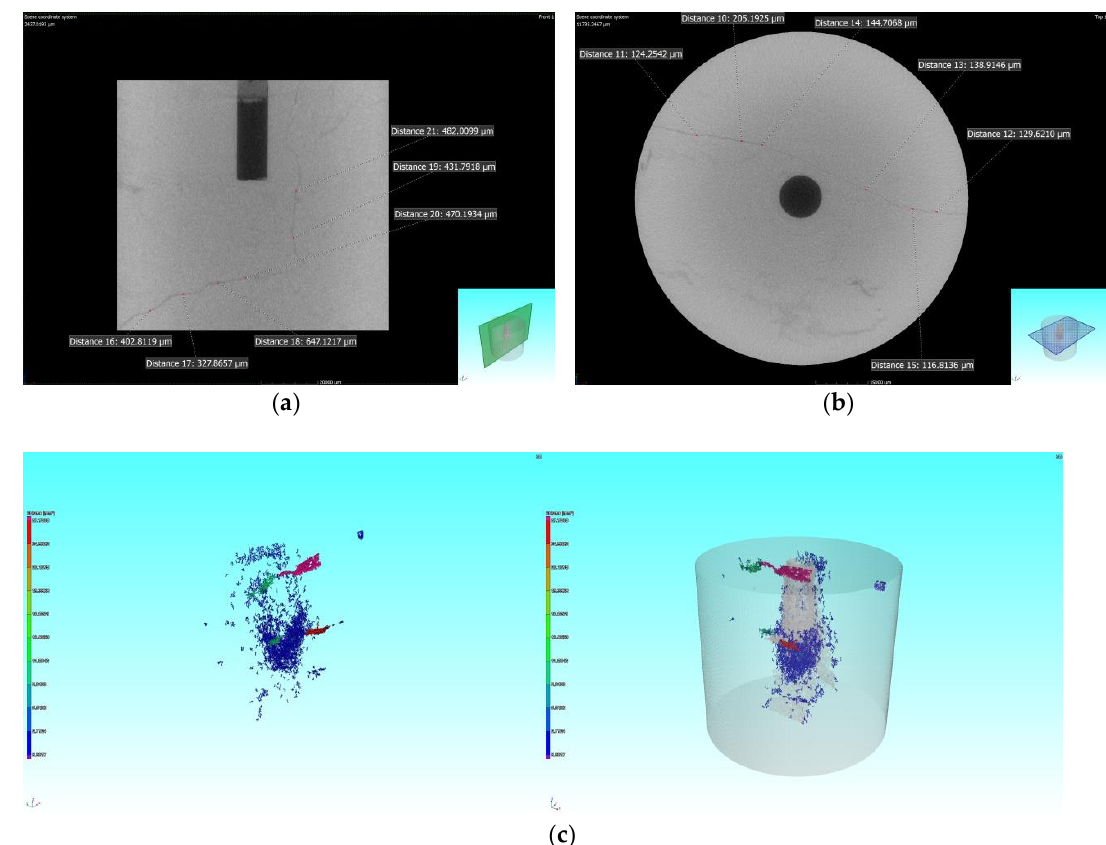
Figure 8. Fracture morphology after hydraulic fracturing of specimen using slick water: ( a ) CT scanning along the axis; ( b ) CT scanning perpendicular to the axis; ( c ) fracture spatial morphology.